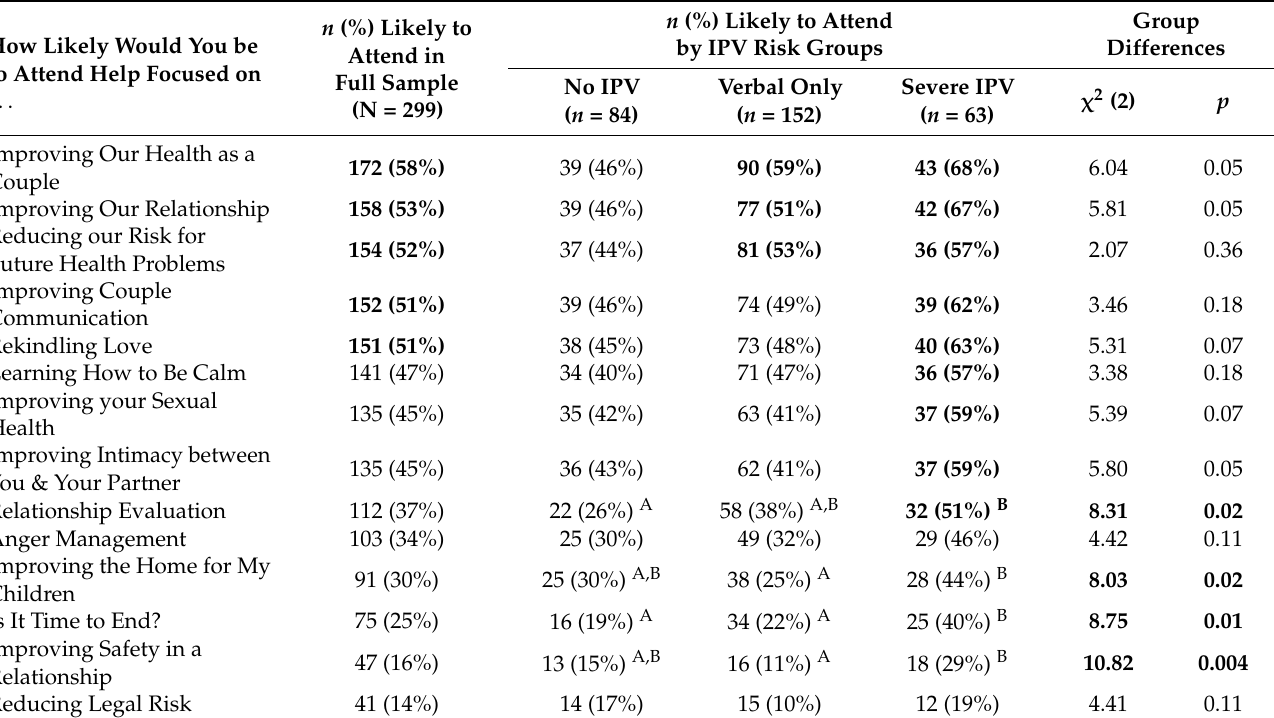
Table 4. Participants Likely to Attend Treatments Addressing Specific Concerns by Intimate Partner Violence (IPV) Risk